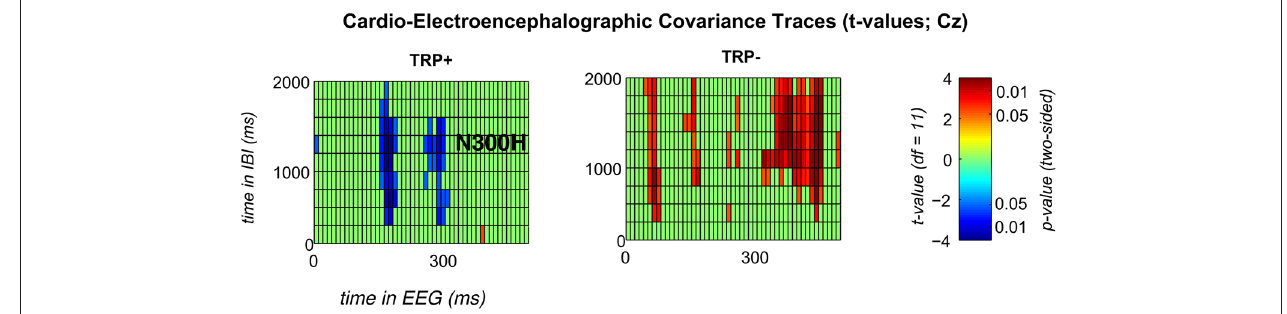
FIGURE 2 | Significant t -values for feedback-locked CECTs at channel Cz following placebo (left) or acute tryptophan depletion (right). T -values are thresholded with p < 0 . 05 (two sided). Any non-significant t -values are plotted in green color.